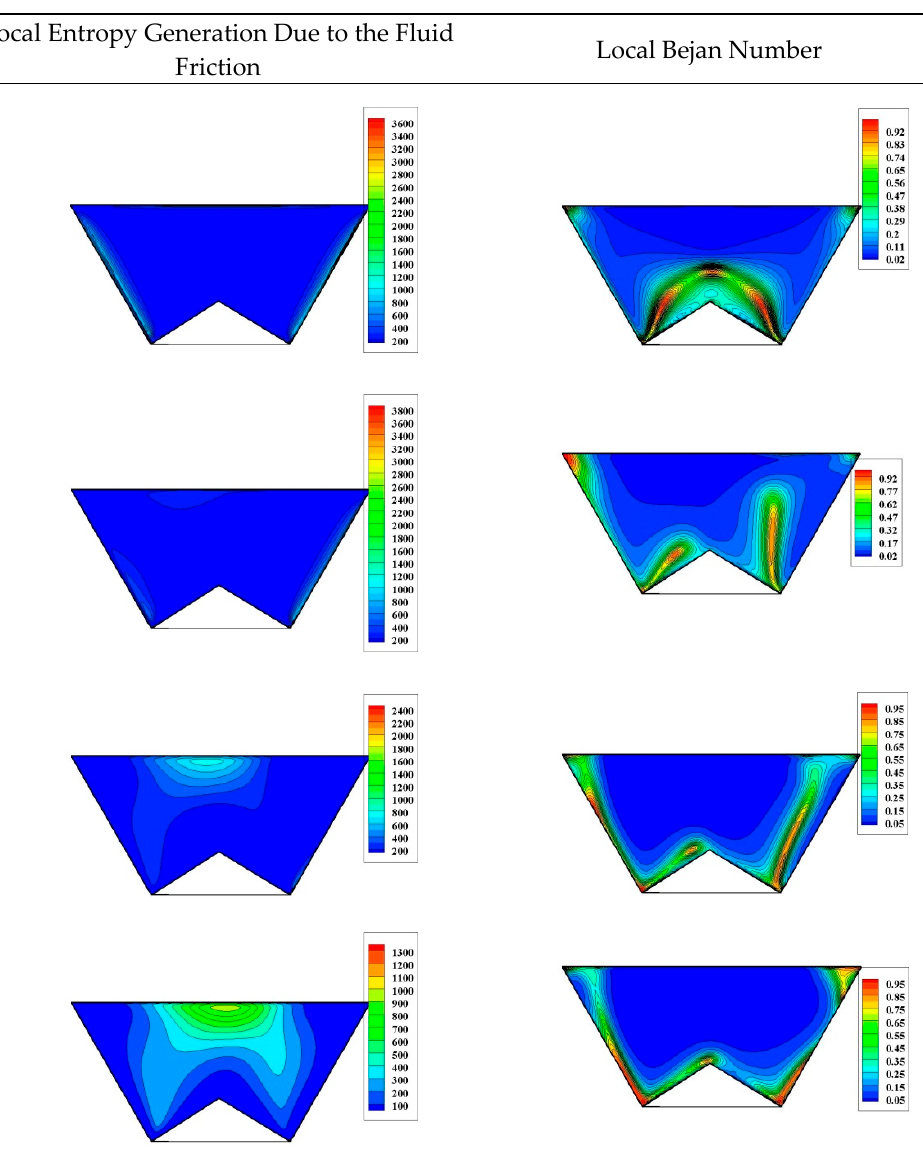
Figure 5. Features of the local entropy generation due to the fluid friction and local Bejan number for the variation of the inclination angle γ ( γ = 0, π , π , π ) at Ra = 10 6 , Ha = 15, H = 0.1, φ Al = φ Cu = 1%, Φ = π 6 3 2 .